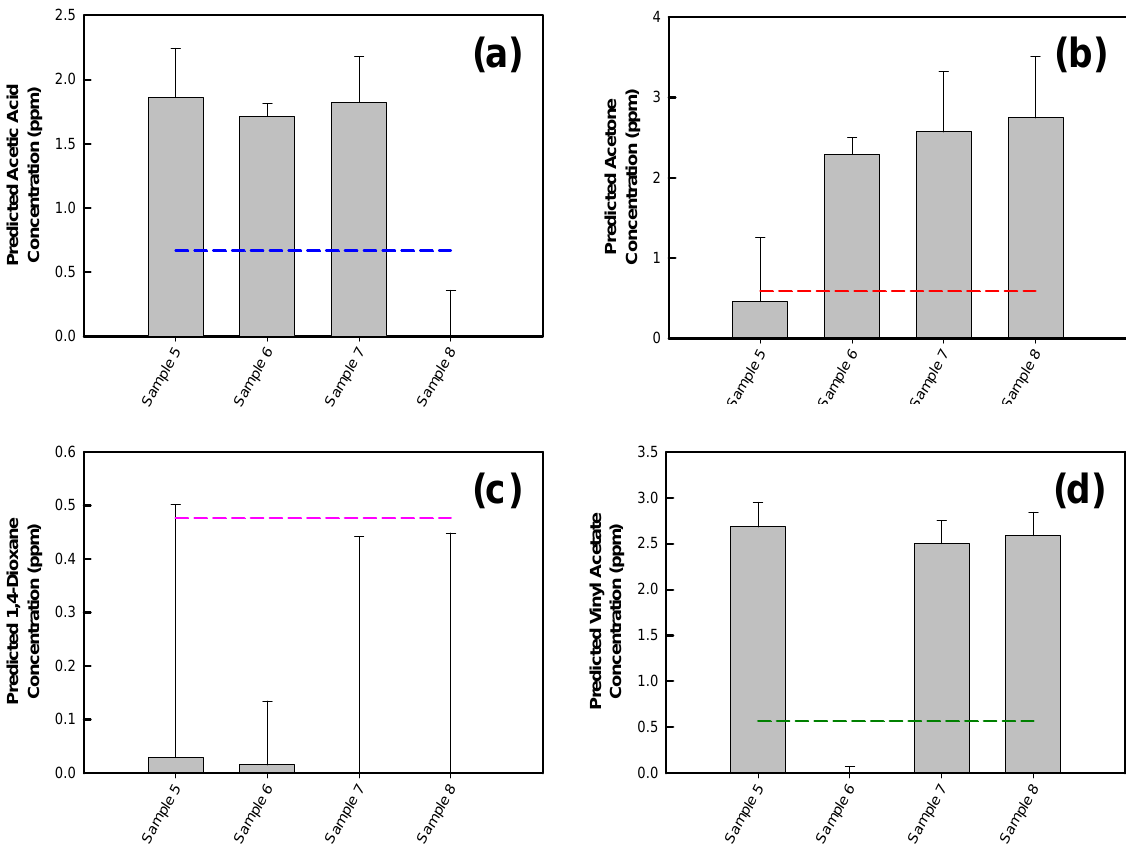
Figure 12. Identification of mixture samples using (a) acetic acid-specific algorithm; (b) acetone-specific algorithm; (c) 1,4-dioxane; and (d) vinyl acetate-specific algorithm. Classification for each analyte is based on 4 PCs. The threshold concentration for each analyte is represented by a dotted